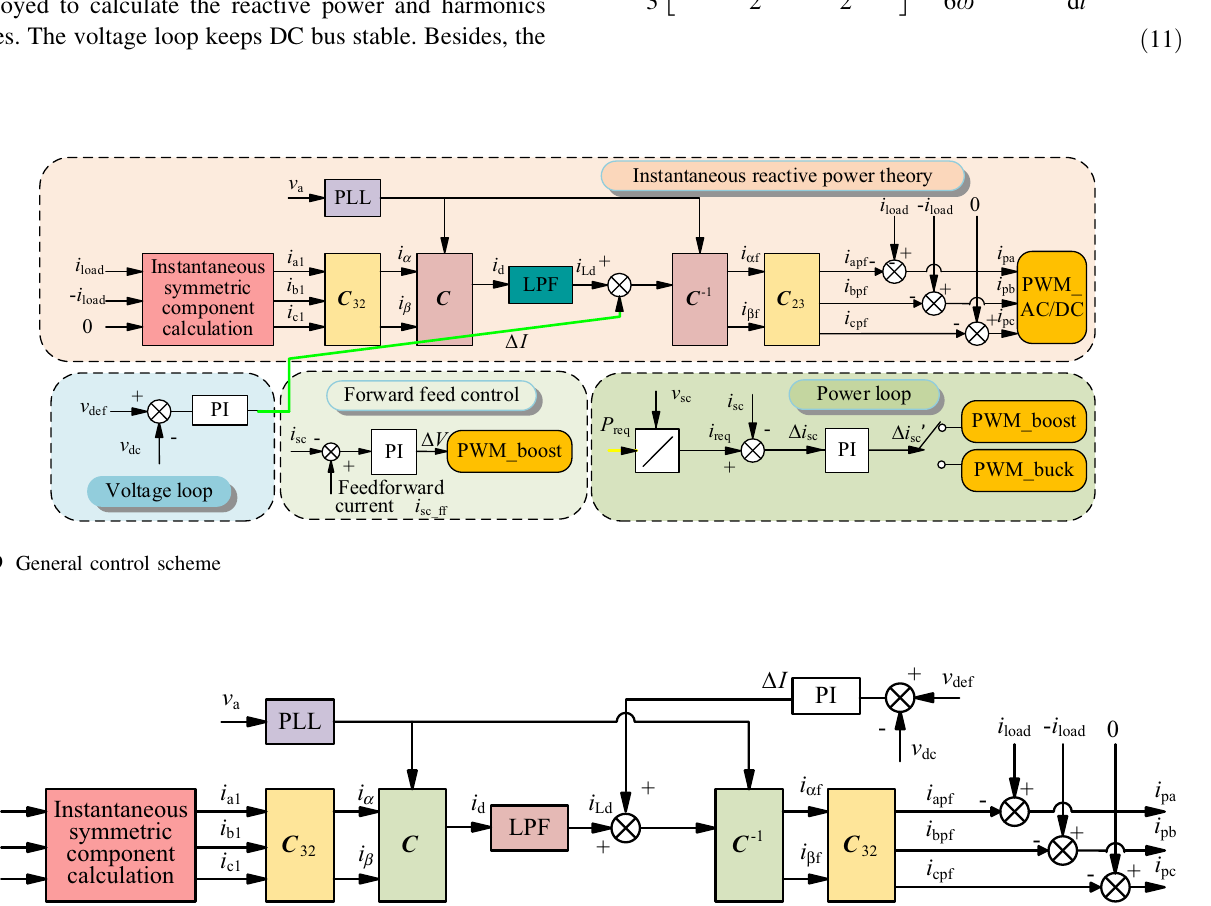
Fig. 10 Coordinated control strategy of AC–DC